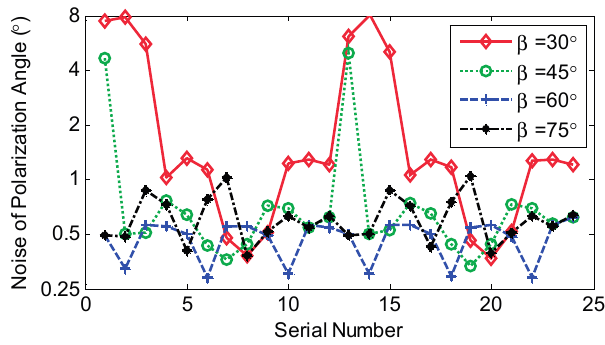
Figure 7. Noise of polarization angle on different β